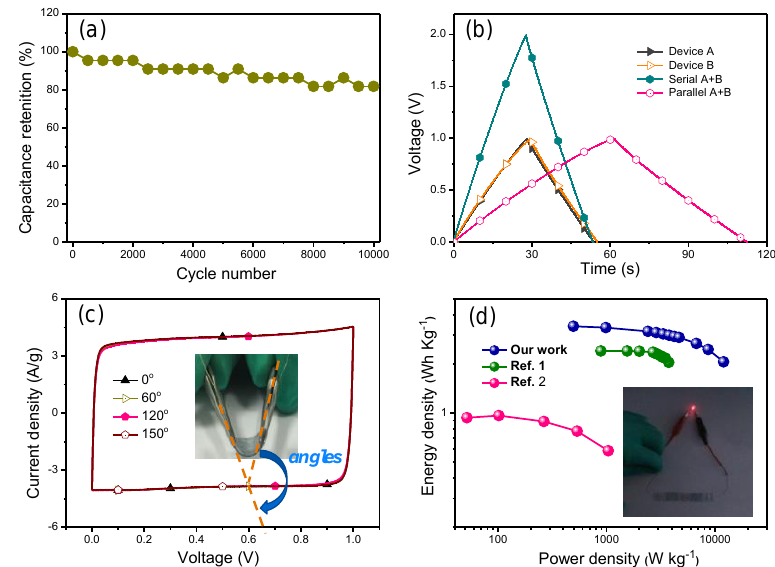
Figure 5. ( a ) Cycling stability of the S-PH1000 supercapacitor at a high scan rate of 100 mV/s. ( b ) GCD profiles of independent, series and parallel S-PH1000 electrodes based on supercapacitors of device A and B at a charge current density of 1 A/g. ( c ) CV curves of the semi-transparent flexible supercapacitors under different bending angles (60°, 120° and 150°). ( d ) Energy density and power density Ragone plots of the PEDOT-based supercapacitors in our work and reported in the literatures. Ref. 1 denotes the reference of ACS Nano , 2014, 8, 1500 while Ref. 2 denotes Energy Environ. Sci. 2015, 8, 1339. The inset is the demonstration of the supercapacitors driving a light-emitting diode.